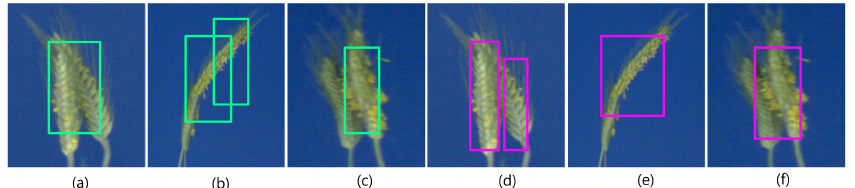
Figure 10. Overlapping/occluding spikes in barley/rye dataset: ( a – c ) Faster-RCNN failed to detect overlapping spikes as separate objects in the majority of cases and ( d – f ) YOLOv3, sometimes managed to separate occluding spikes as in ( d